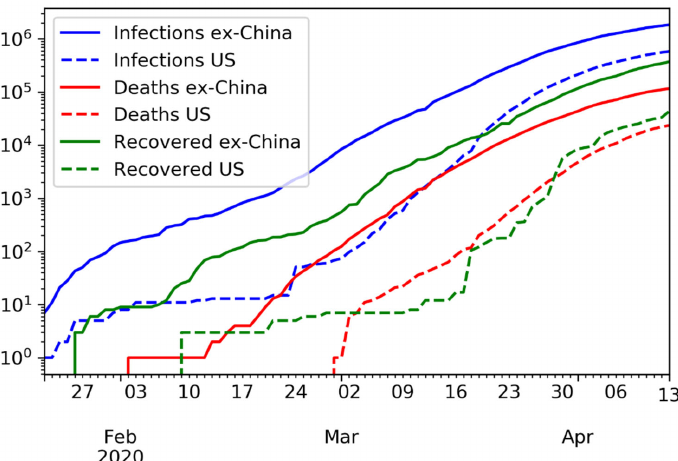
Figure 8. Time series of confirmed infections, deaths, and recovered, in logarithmic scale. In the U.S., the number of recovered cases is barely above the number of deaths, likely due to limited testing.